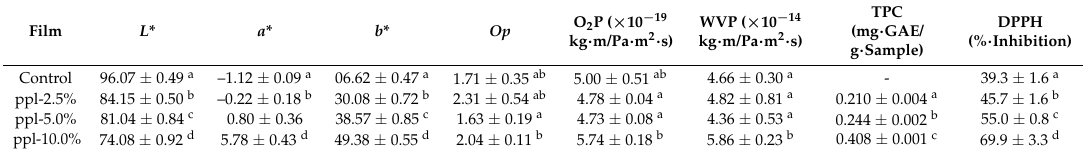
Table 2. Color ( L *, a *, b *), opacity ( Op ), oxygen permeability (O 2 P), water vapor permeability (WVP), total phenol content (TPC), and DPPH antioxidant activity of the RS/CMCh/ppl blended